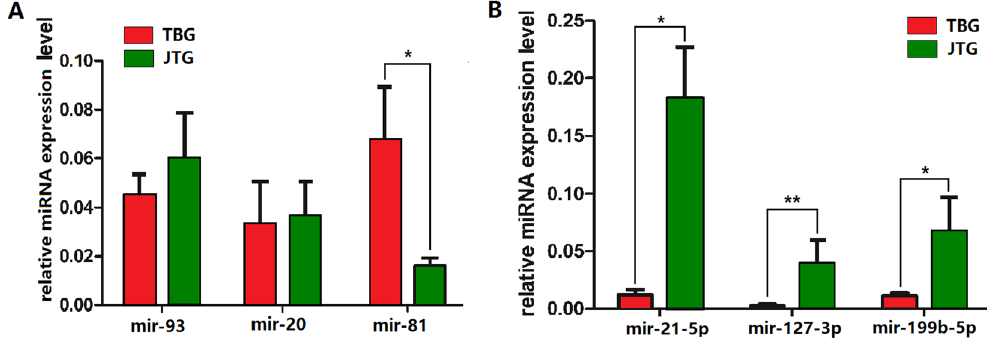
Figure 5. Validation of sequencing results by RT-qPCR. ( A ) A bar graph showing novel miRNAs, and ( B ) a bar graph showing known miRNAs. Error bars indicate mean ± SE ( n = 5 per breed), * p < 0.05, ** p <